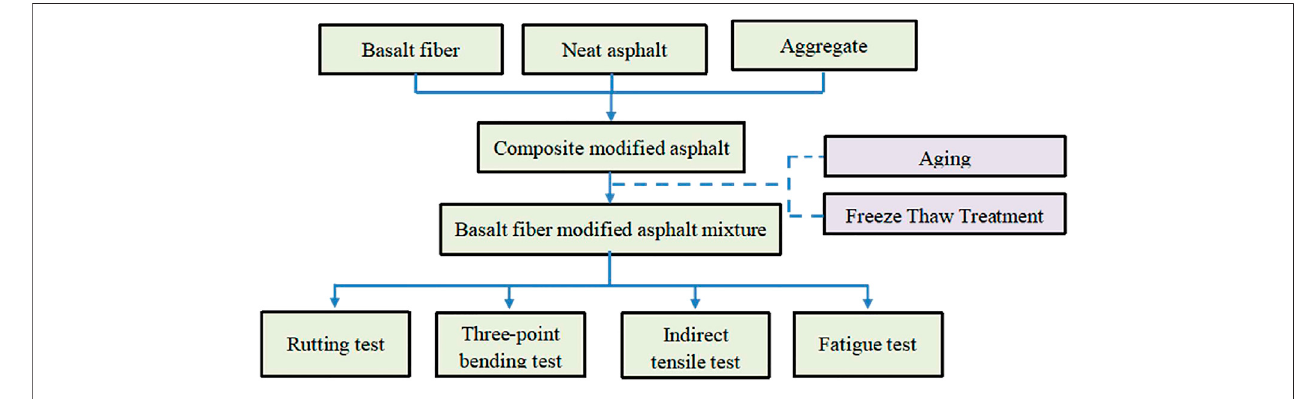
FIGURE 1 | Test procedure.